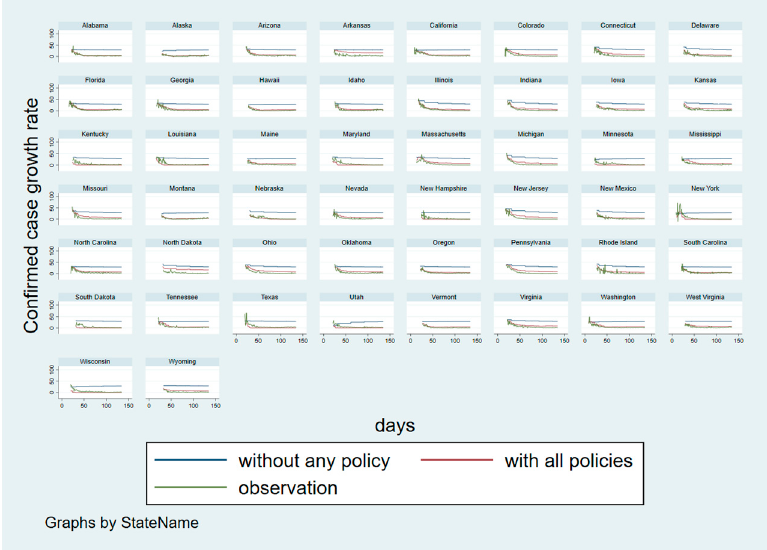
Figure 4. Counterfactual analysis: state-specific time trends for the confirmed case growth rate with and without social distancing